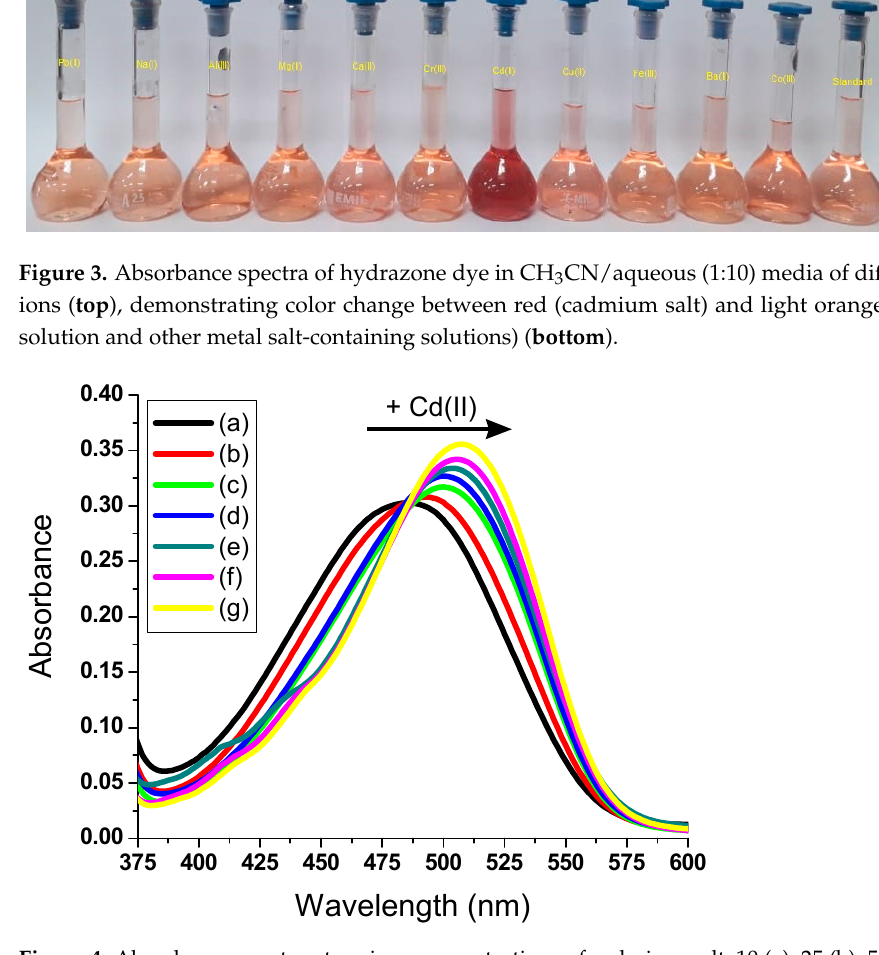
Figure 4. Absorbance spectra at various concentrations of cadmium salt; 10 (a), 25 (b), 50 (c), 100 (d), 150 (e), 200 (f), and 250 (g) ppm.